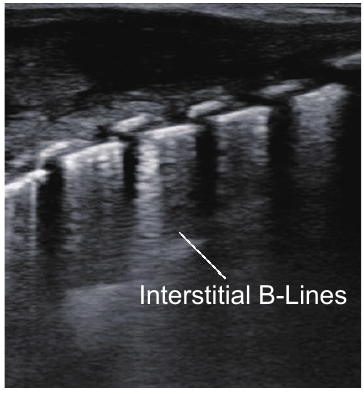
Figure 5 Alveolo-interstitial Syndrome characterized by abnormal B-lines which are echogenic ring down artifacts, and are 7mm apart arising from the pleural line and are representative of edema involving interlobular septa.